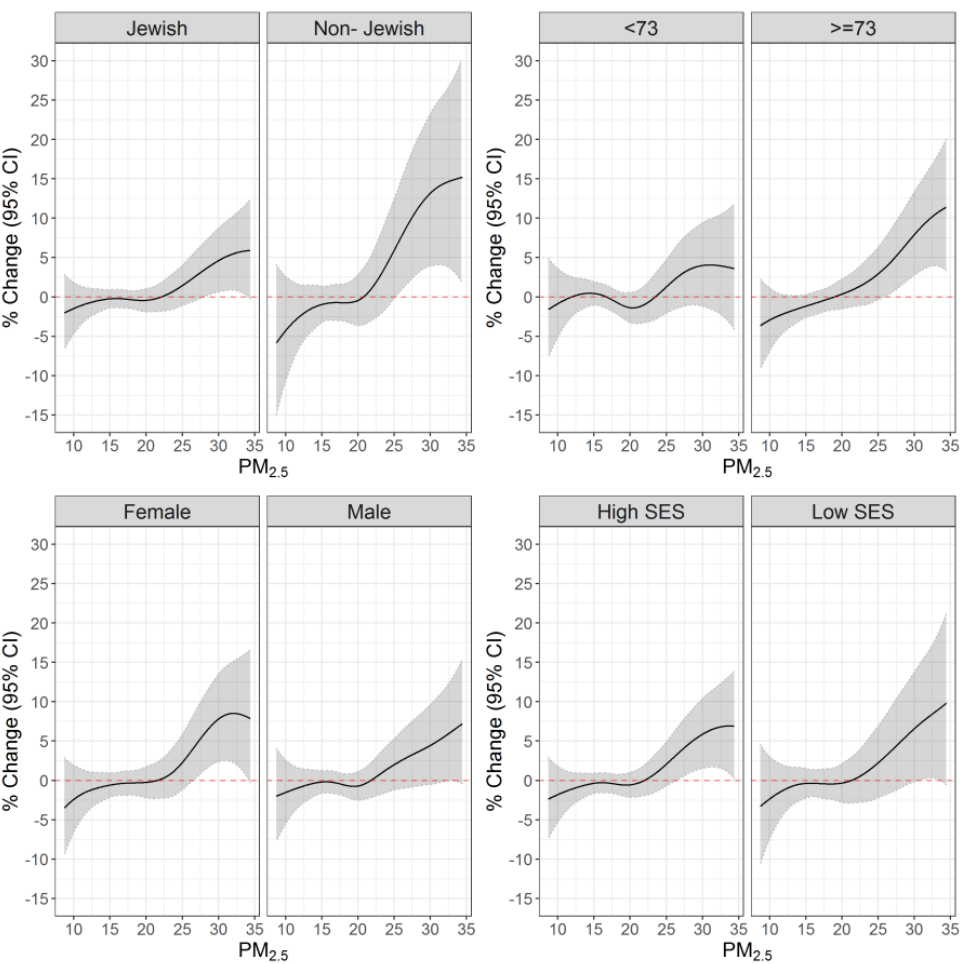
Figure 2. The association between PM 2.5 exposure on the event day and ischemic stroke/TIA stratified by age, sex, ethnicity, and SES. Figure 2 shows the associations between PM 2.5 exposure on the event day and ischemic stroke/transient ischemic attack (TIA), stratified by ethnicity (Jewish versus non-Jewish), median age (<73 years versus 73 years and older), sex (male versus female), and neighborhood socioeconomic status (SES) (lower than the median score versus median score or higher). Results were obtained from conditional logistic regressions, in which control days were selected within the same month and year as the case day and matched by the weekday. Models were adjusted for a spline function of daily mean temperature.